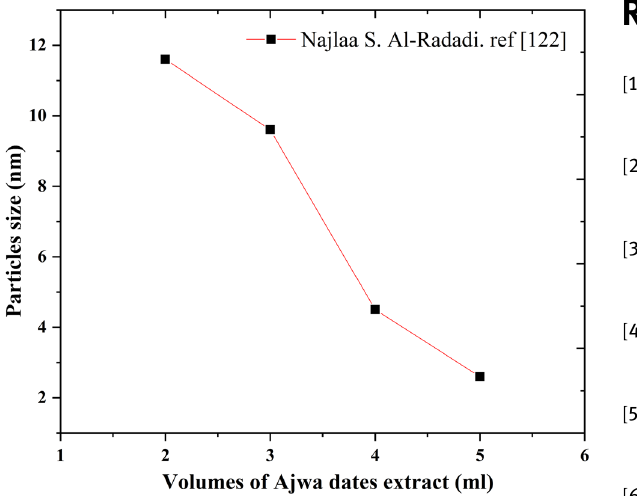
Figure 8: The e ff ect of di ff erent concentration of Ajwa extract on the particle size variation of Pt NPs with 5 mL of H 2 PtCl 6 stock solutions after 10 h at the ordinary temperature, adapted from ref. [ 122 ]